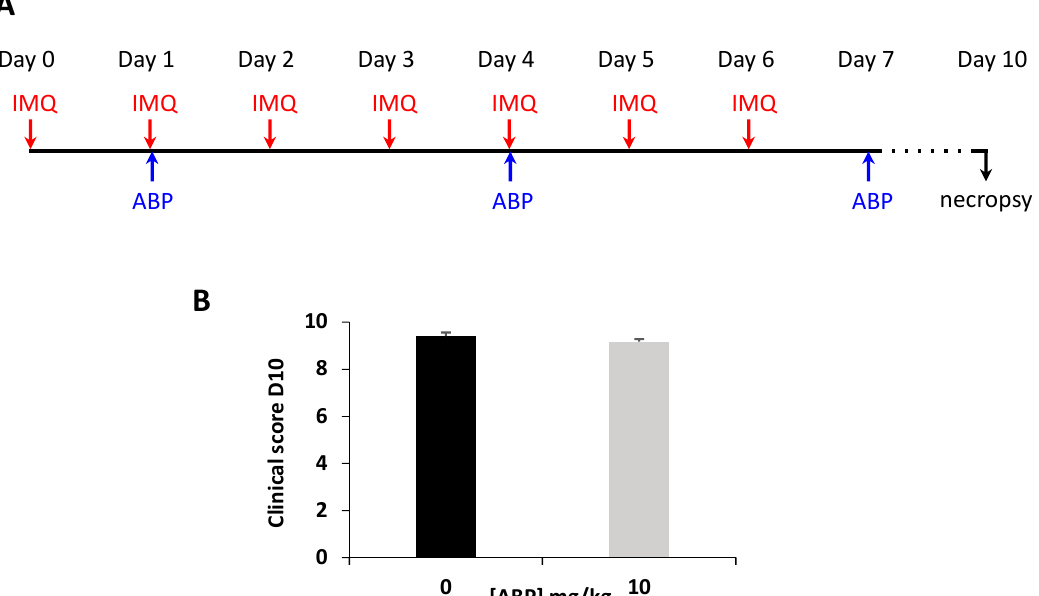
Figure 2. Clinical assessment of the efficacy of the ABP dendrimer when administered intravenously to imiquimod (IMQ)-induced psoriatic mice. ( A ) Time line of the study. ( B ) Clinical score at day 10 for control psoriatic mice (black bar) and mice treated with 10 mg/kg of the ABP dendrimer every 3 days ( n = 10 mice in each group).